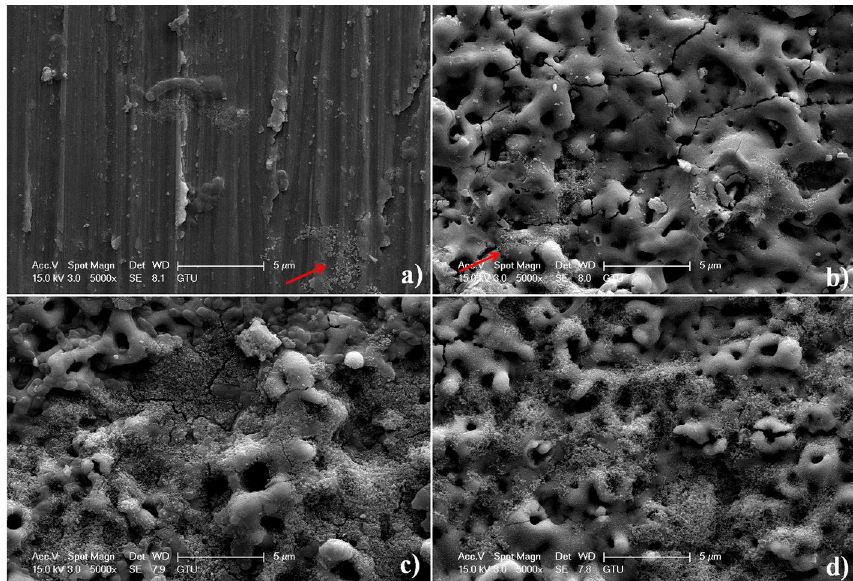
Figure 8. Surface topography of the surfaces at post-immersion in SBF for 10 days: ( a ) bare Zr, ( b ) MAO- 15-Ag, ( c ) MAO-30-Ag and ( d ) MAO-45-Ag.